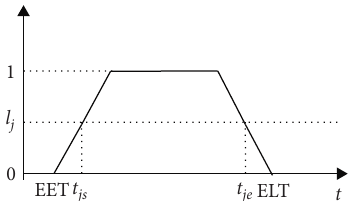
Figure 2: Delivery time corresponding to a specific satisfaction